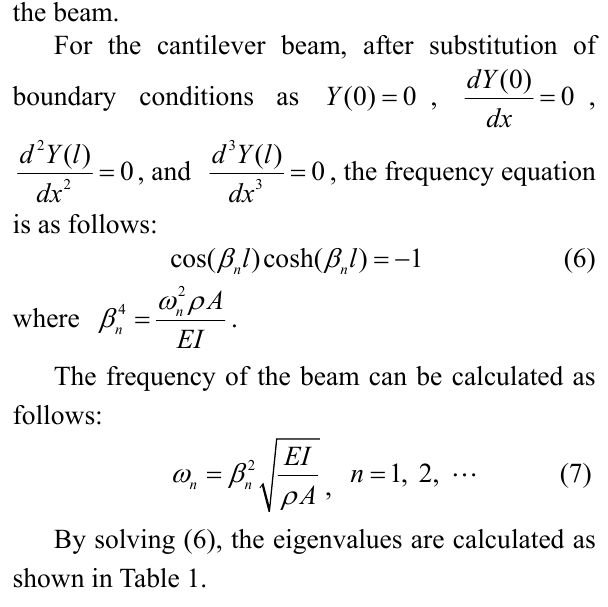
Table 1 Eigenvalues of characteristic